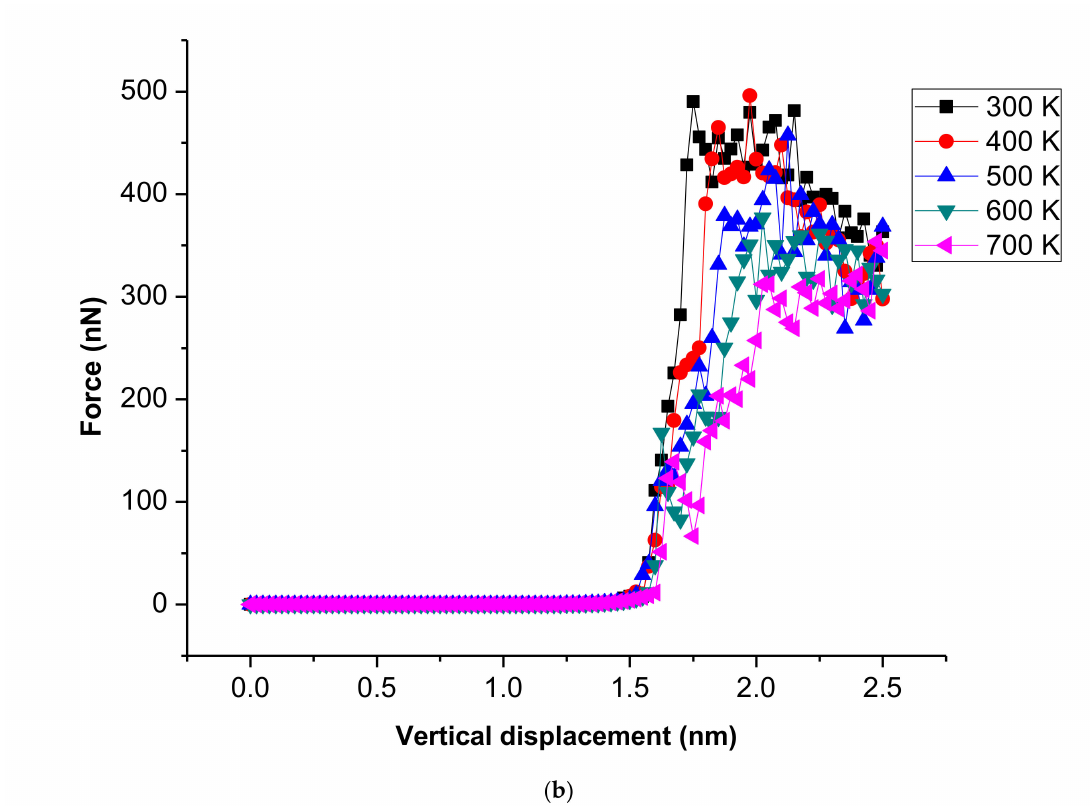
Figure 3. ( a ) The resultant computed temperature distributions on vanadium (V) thin film at 0.5 Å / ps loading rate for di ff erent temperatures during the loading process and ( b ) the Force-displacement curves duringnanoindentationonniobium(Nb)thin-filmduring0.5Å / psloadingrateatdi ff